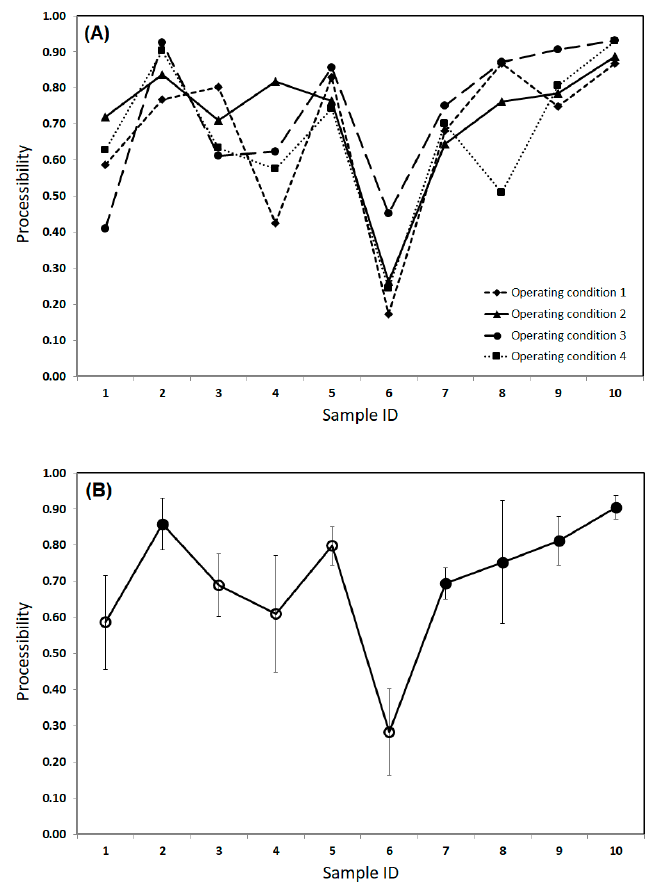
Figure 4. Processability for the ten samples. ( A ) measured for each of the four operating conditions. ( B ): averaged value for each sample based on the four operating conditions; open and filled circles for brown and dark froths, respectively.